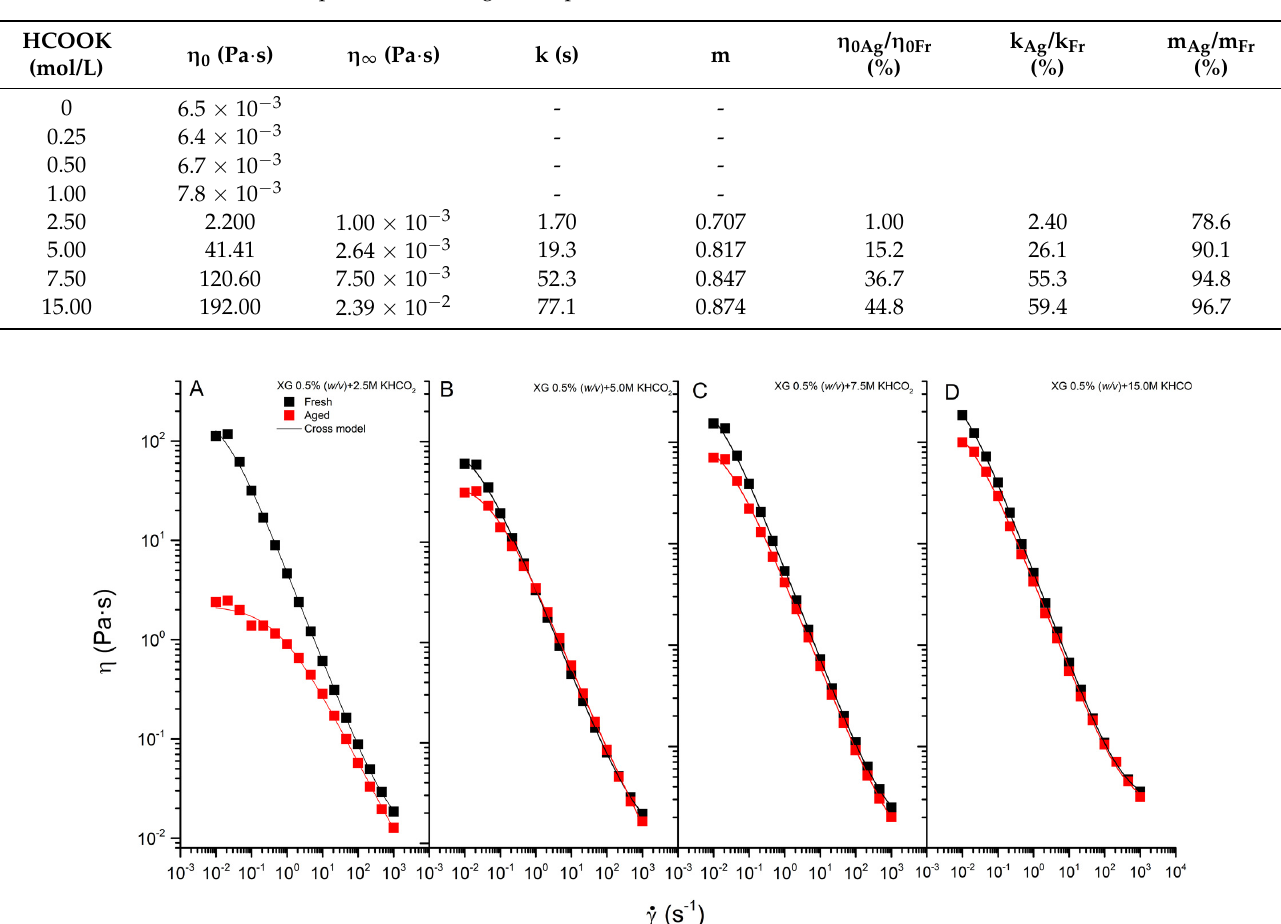
Table 2. Cross model parameters for aged samples XG 0.5% ( w/v ) as a function of the formate concentration.